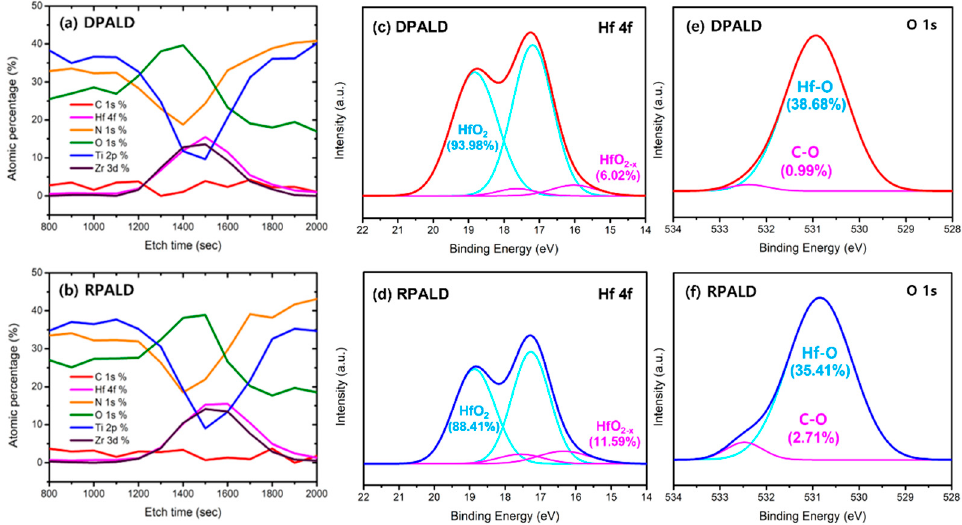
Figure 6. HZO thin films deposited by DPALD and RPALD methods: ( a , b ) XPS depth profiling, ( c , d ) Hf 4f, and ( e , f ) O 1s narrow scan XPS patterns.